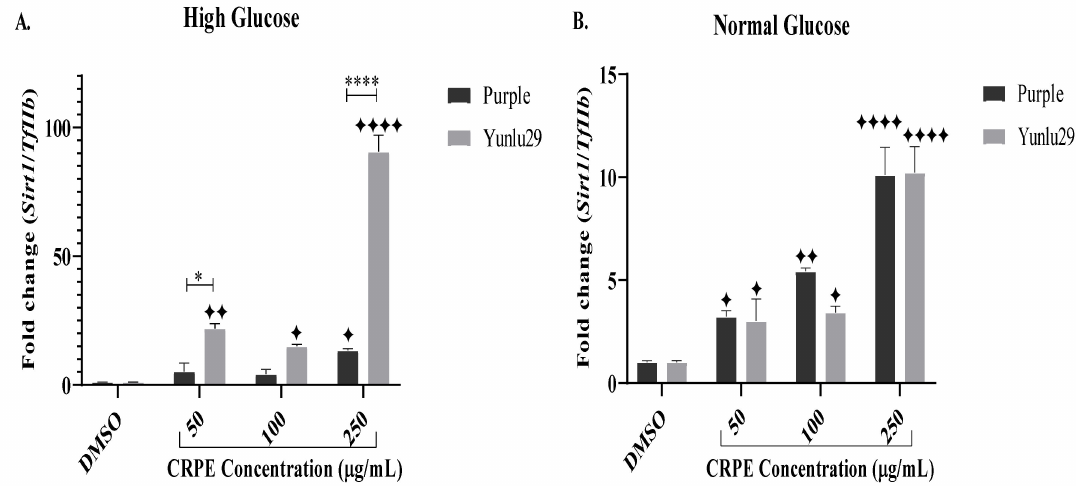
Figure 3. Expression of Sirt1 in INS-1E cells. A ) high glucose (25 mM). B ) normal glucose (11.1 mM). n = 3. Stars indicate significant di ff erences between extracts and DMSO, where (cid:70) p < 0.05, (cid:70) (cid:70) p < 0.01, (cid:70)(cid:70)(cid:70)(cid:70) p < 0.0001. Asterisks indicate significant di ff erences between the extracts, where * p < 0.05, **** p < 0.0001; two-way ANOVA with Turkey’s multiple comparison post hoc test. Data is presented